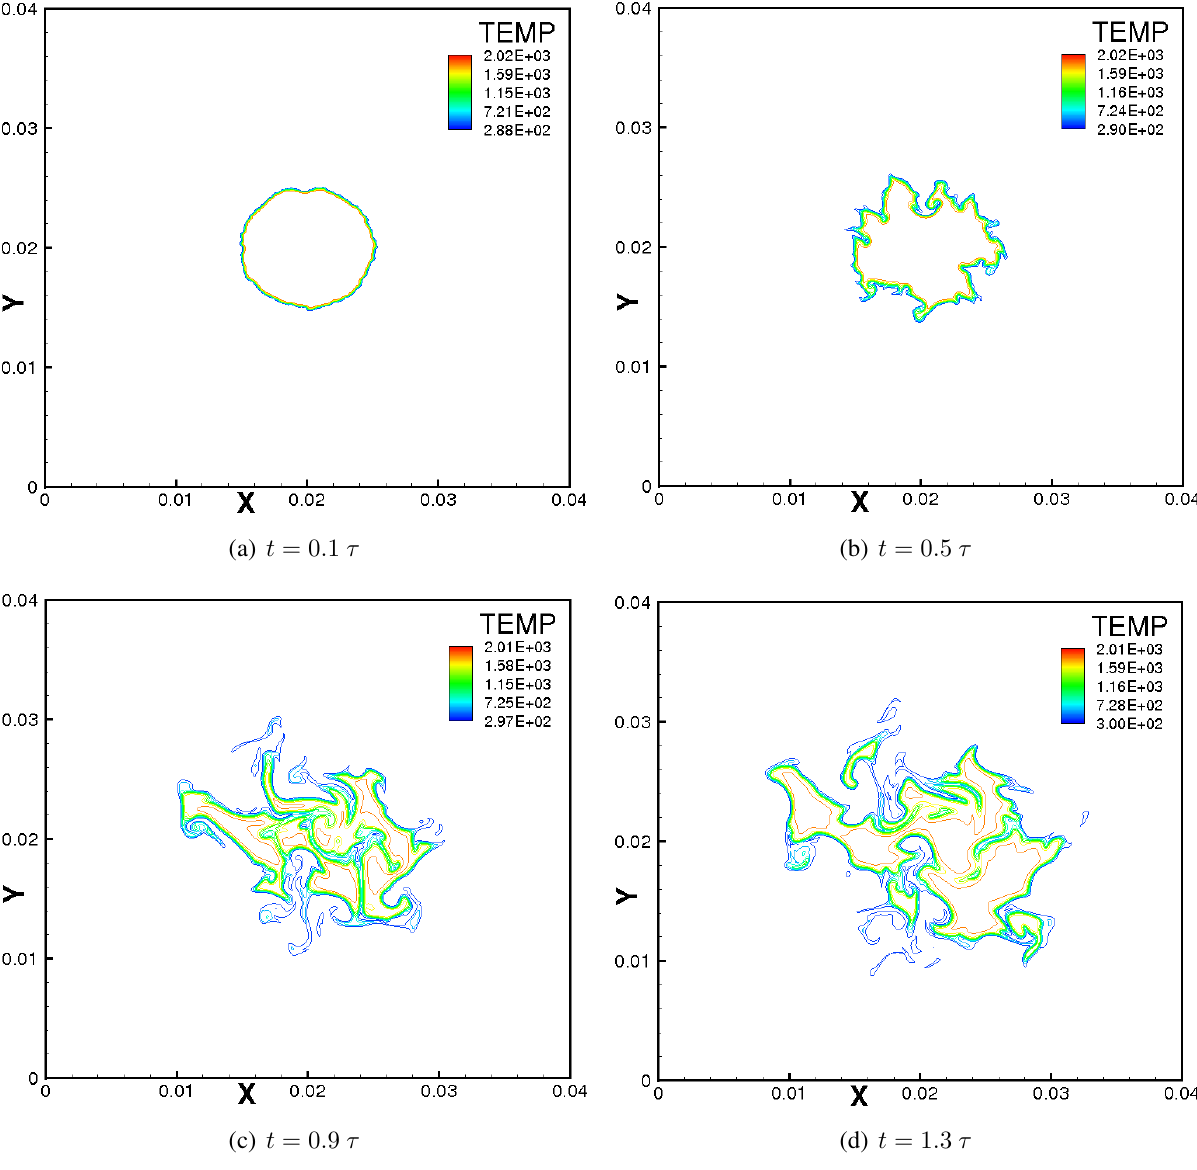
Figure 2. Time evolution of the iso-contours of temperature ( case 7 , Re mixture equivalence ratio Φ = 0 . 8 at t = 0 . 1 τ , 0 . 5 τ , 0 . 9 τ and 1 . 3 τ